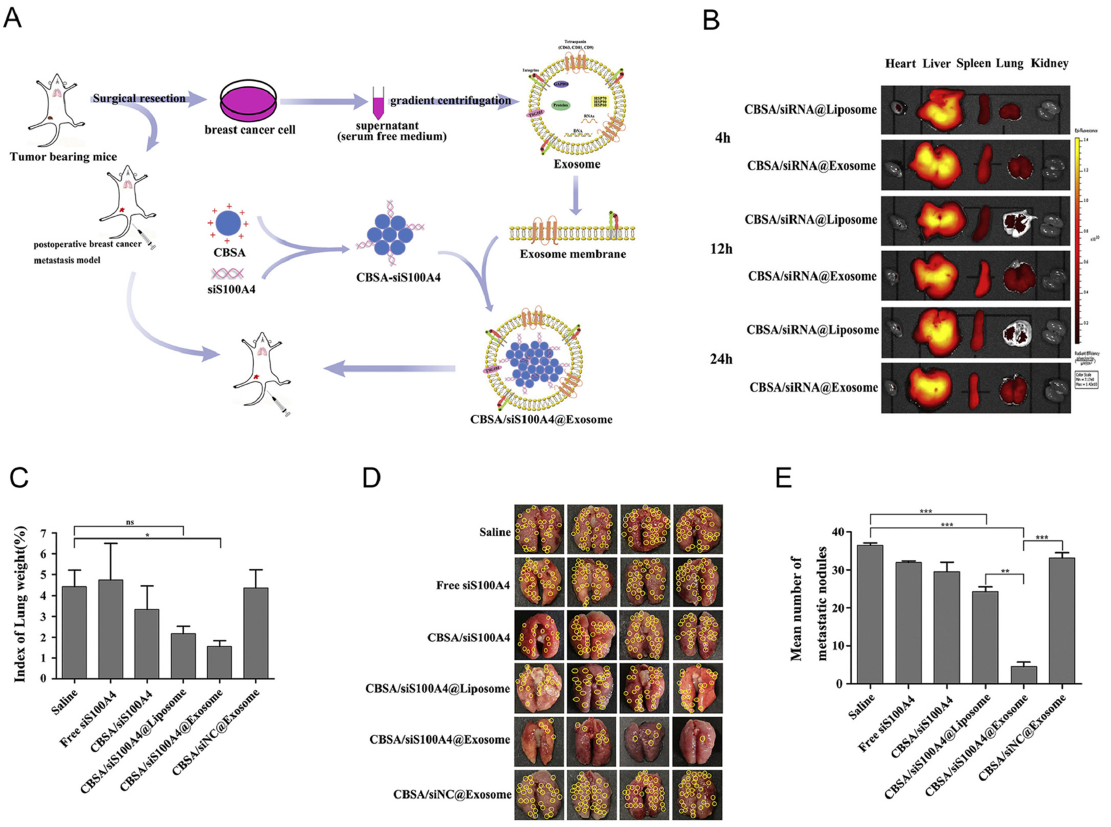
Figure 5. ( A ) Illustration of the CBSA/siS100A4@exosome to suppress postoperative breast cancer lung metastasis. ( B ) EX vivo images of major organs from mice treatment with CBSA/siRNA@Liposome and CBSA/siRNA@Exosome at different time points post-injection. ( C ) Weight differences in lung tissues after treatment with saline, free siS100A4, CBSA/siS100A4, CBSA/siS100A4@Liposome, CBSA/siS100A4@Exosome and CBSA/siNC@Exosome. (n = 4, * p < 0.05; ns, not significant). ( D ) Lung tissue images of postoperative lung metastases mice after treatment with saline, free siS100A4, CBSA/siS100A4, CBSA/siS100A4@Liposome, CBSA/siS100A4@Exosome and CBSA/siNC@Exosome (metastatic nodules were marked by yellow circles). ( E ) Mean number of lung metastatic nodules of different treatment groups (n = 4, ** p < 0.01; *** p < 0.001). Reprinted with permission from [115]. Copyright 2019 ELSEVIER